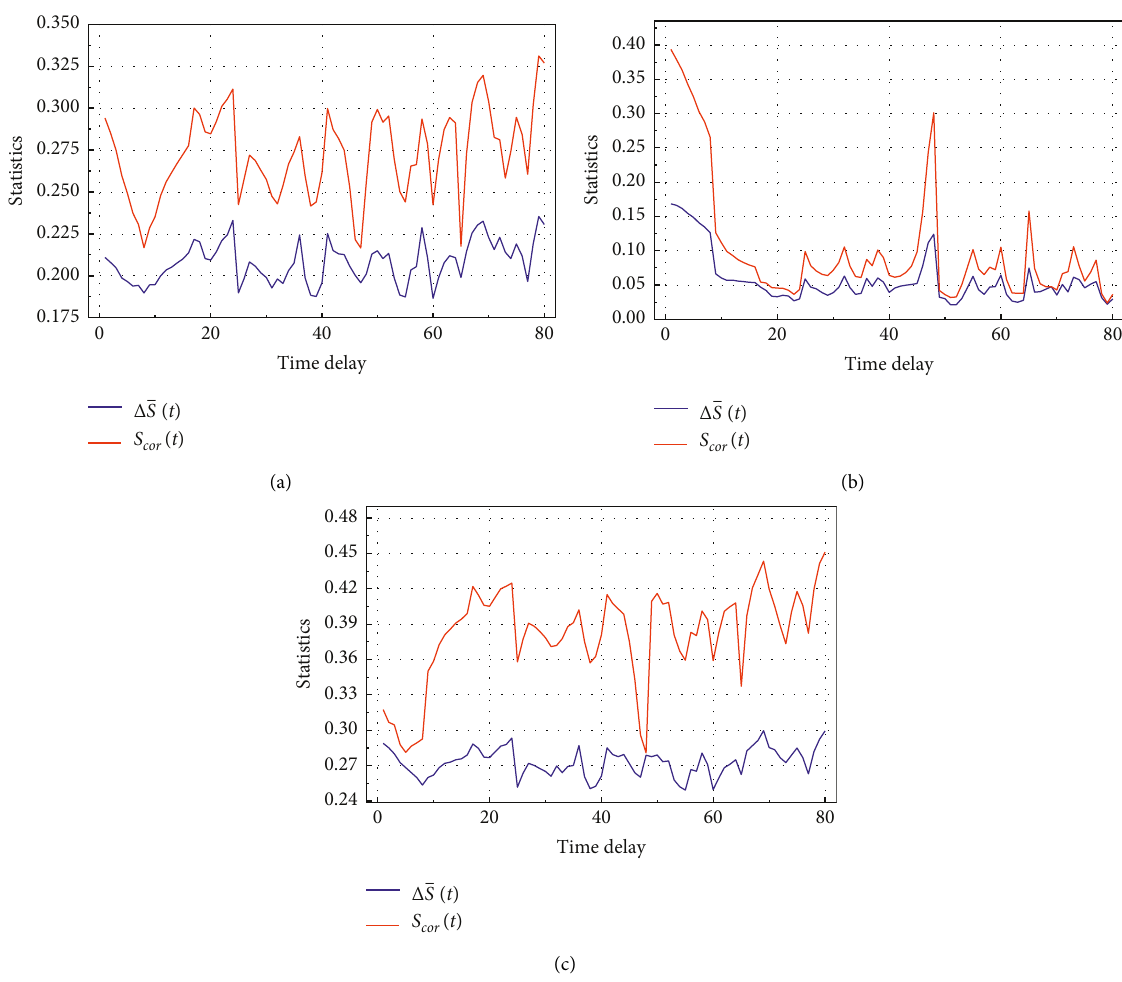
Figure 9: Experimental results of the C-C algorithm under each measurement method: (a) the L 2 norm measurement; (b) the infinite norm measurement method; and (c) the fused norm